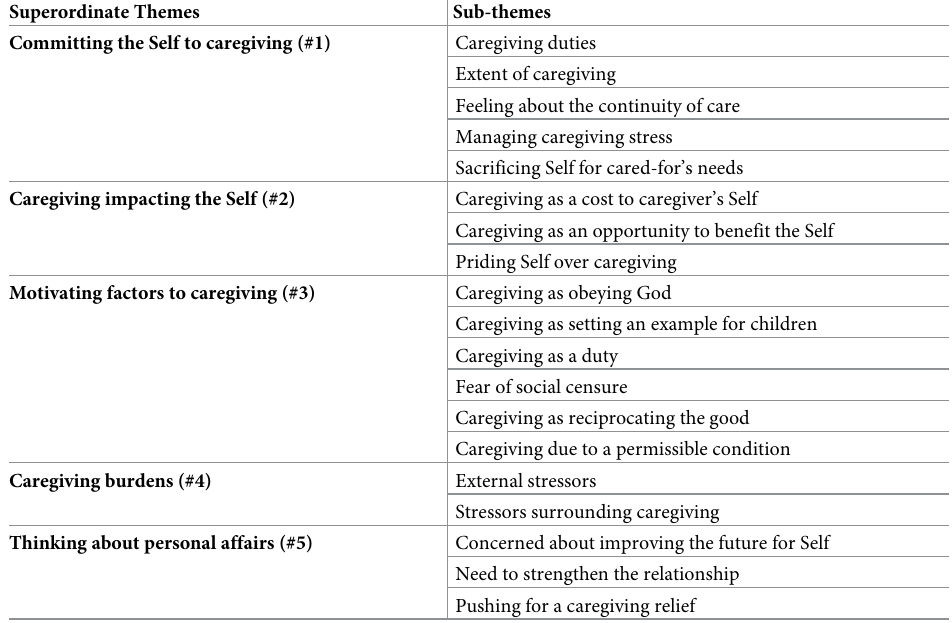
Table 2. Superordinate themes and sub-themes reflecting caregiver